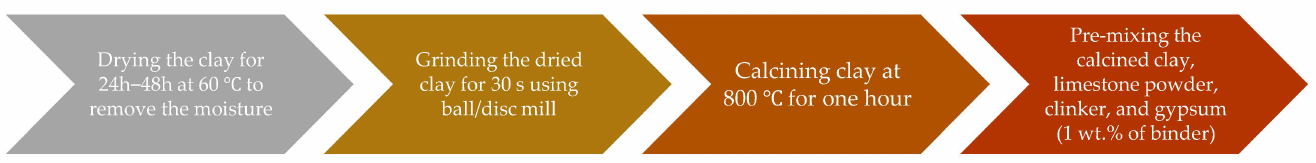
Figure 2. Steps involved in the preparation of LC3 in the lab for this